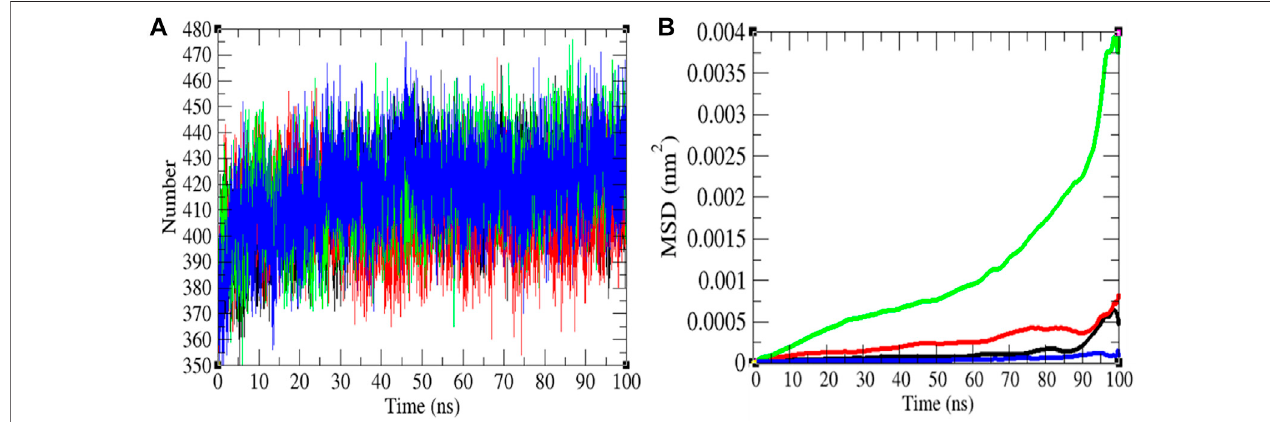
FIGURE 5 | Hydrogen bonds and MSD. (A) The H-bond estimation between M-S chains of the SARS-CoV-2 S protein was calculated. The color codes have the same meaning as described in Figure 2 . (B) The MSD of the SARS-CoV-2 S protein at 0 ° C (black), 20 ° C (red), 40 ° C (green), and 60 ° C (blue), respectively.